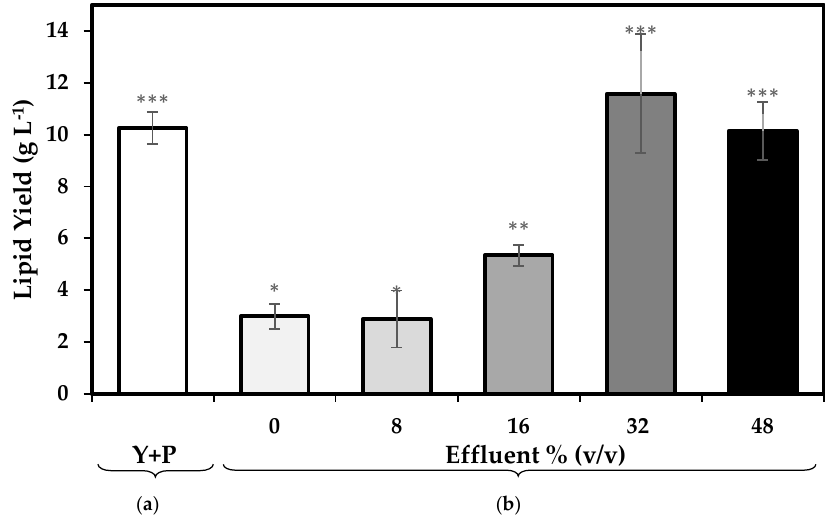
Figure 2. Comparison of lipid productivity of S. limacinum in growth media containing the same carbon (120 g L − 1 crude glycerol) concentration and ( a ) yeast and peptone (Y+P) and micronutrients or ( b ) varying volumes of effluent digestate (0–48%) combined with NH 4 Cl that resulted in the same nitrogen (3.3 g L − 1 ) concentrations, without additional micronutrients. Values are represented as mean ± standard deviation of triplicates, whereas asterisks indicate statistical differences analyzed at a level of p < 0.05